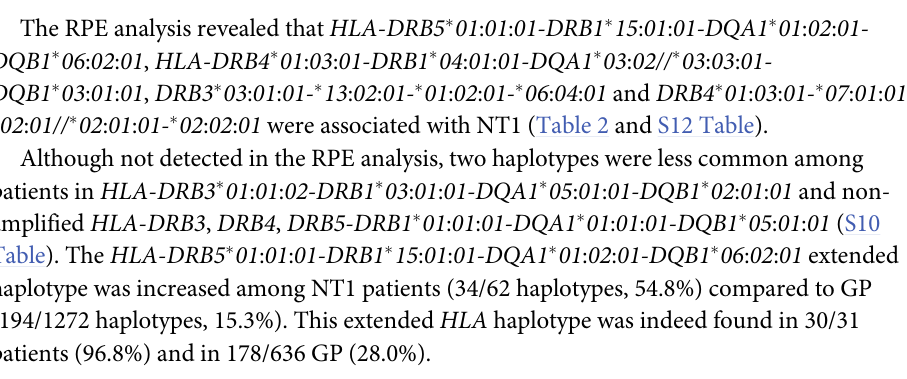
Table). The HLA - DRB5 � 01 : 01 : 01-DRB1 � 15 : 01 : 01-DQA1 � 01 : 02 : 01-DQB1 � 06 : 02 : 01 extended haplotype was increased among NT1 patients (34/62 haplotypes, 54.8%) compared to GP (194/1272 haplotypes, 15.3%). This extended HLA haplotype was indeed found in 30/31 patients (96.8%) and in 178/636 GP (28.0%).